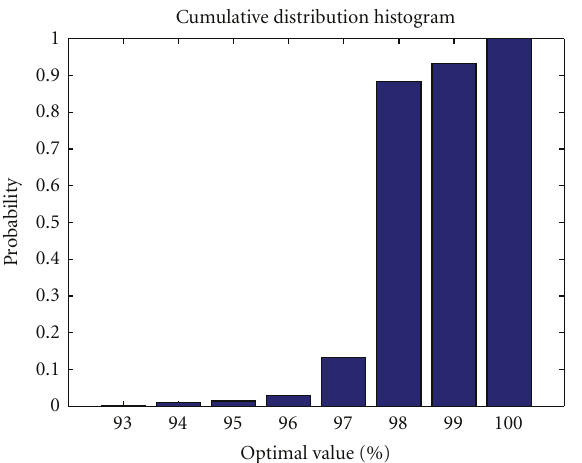
Figure 3: Cumulative distribution histogram to demonstrate gap between optimal and near-optimal scheme.